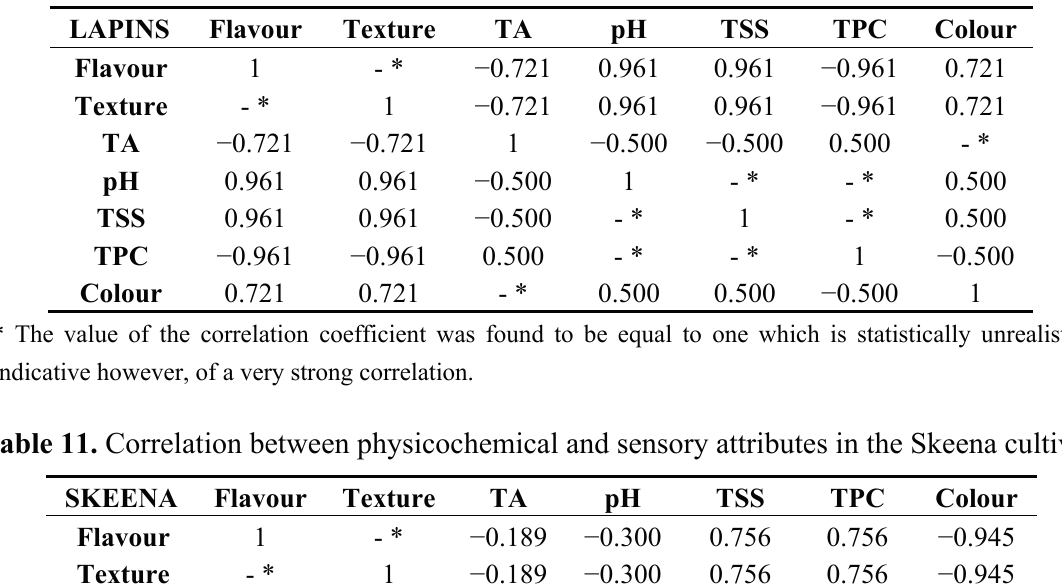
Table 10. Correlation between physicochemical and sensory attributes in the Lapins cultivar.